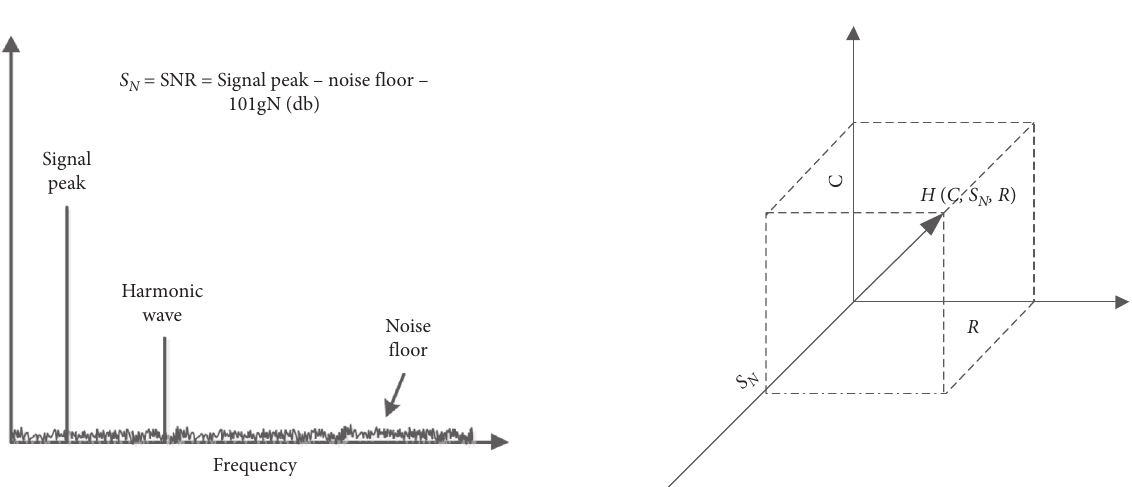
Figure 2: Schematic diagram of SNR calculation based on Fourier transform. Figure 4: Three-dimensional health measurement model.